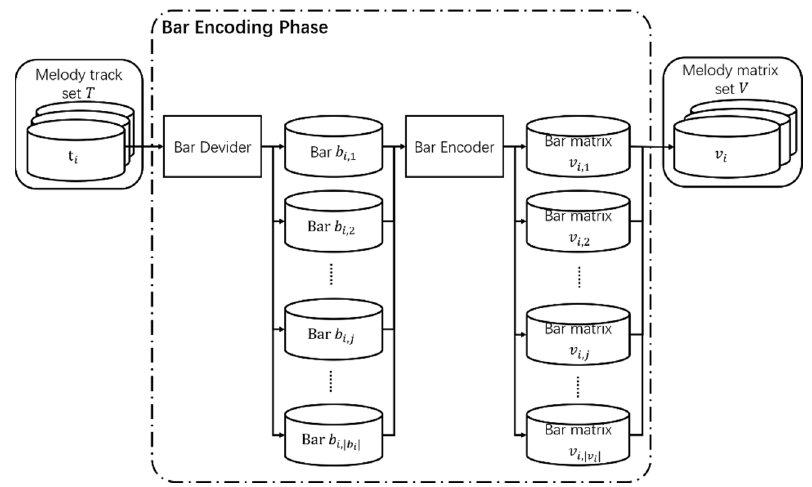
Figure 3. Bar encoding method.